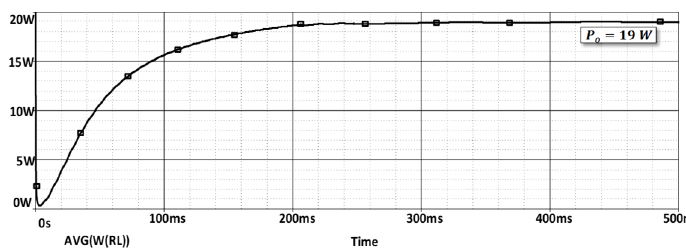
Figure 15. Output current plot of the converter simulated in SPICE.